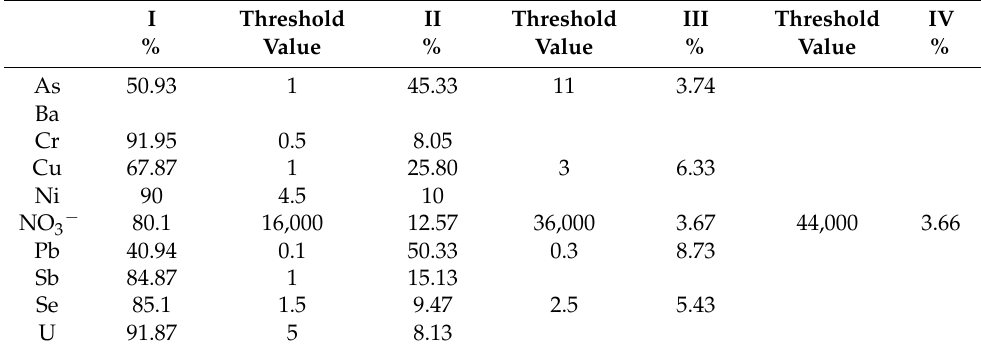
Table 1. Main identified populations with relative percentages and threshold values for selected trace elements (as µ g L − 1